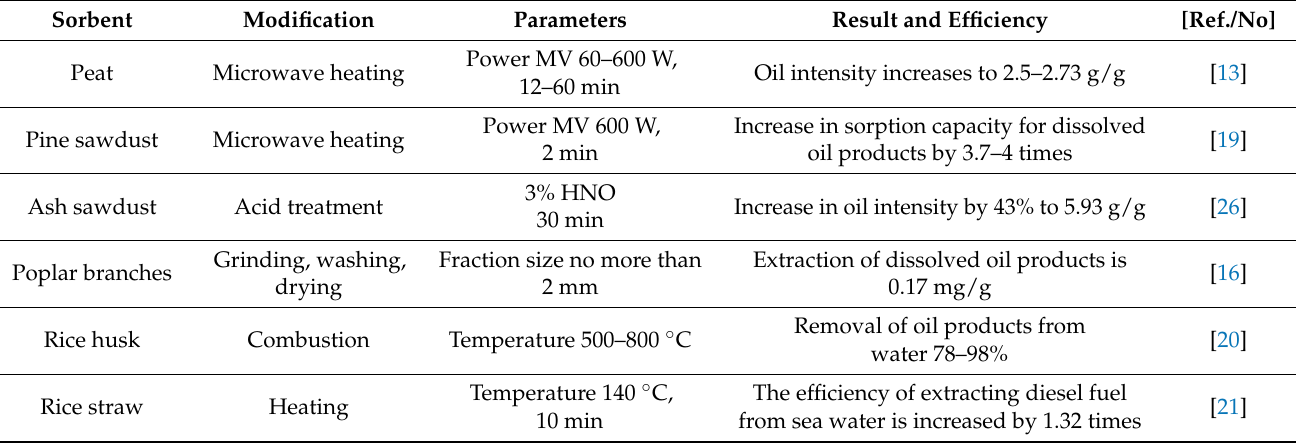
Table 1. The modification and efficient of natural